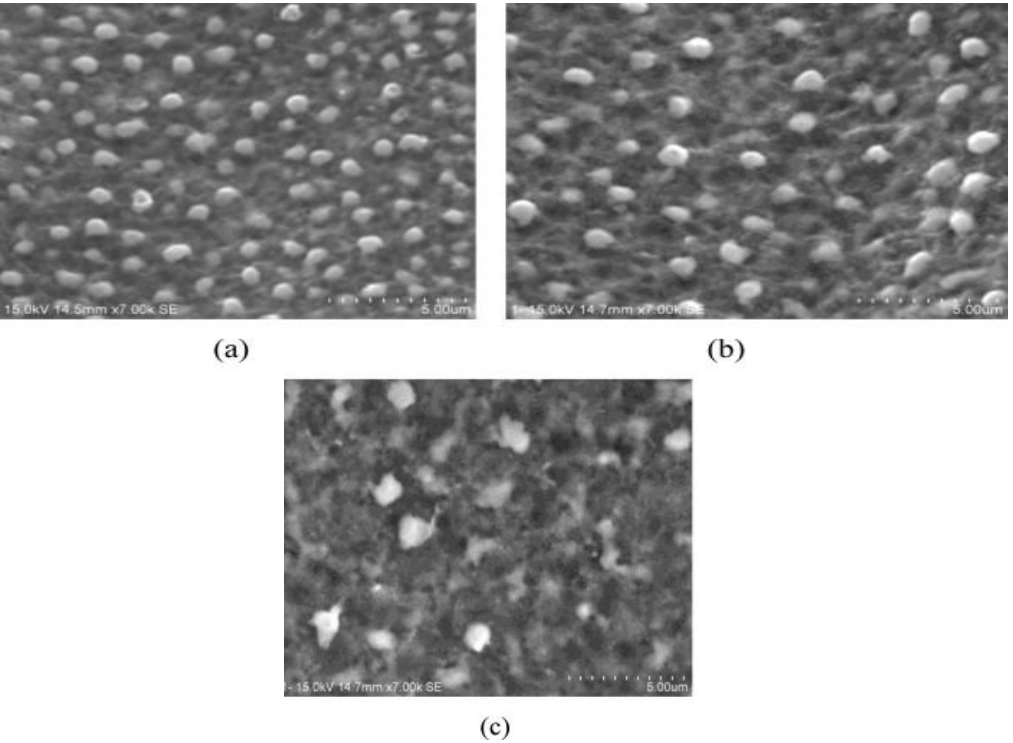
Figure 14. Machined surface at stray capacitance but different levels of voltage with carbon nanofibers addition: ( a ) 60 V ( b ) 80 V ( c ) 100 V. (Reproduced with permission from [110]).